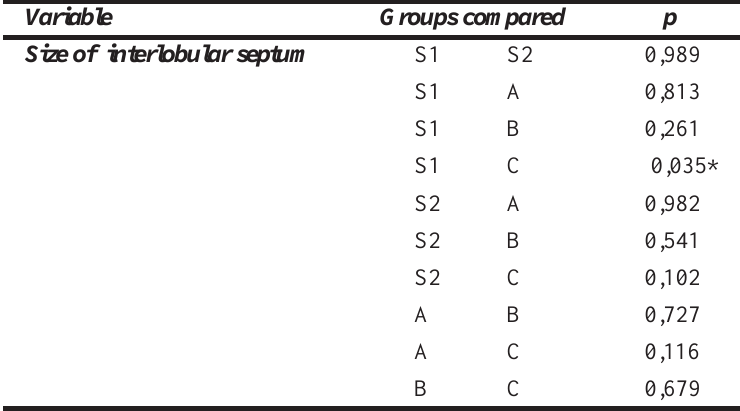
TABLE 5 - Interlobular septum size comparison between groups